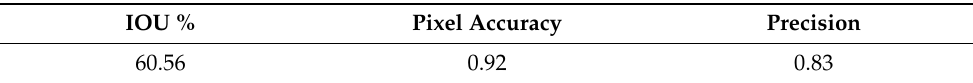
Table 3. Model interference accuracy with UAV dataset in Ratnapura, which is new to the model and used only as test